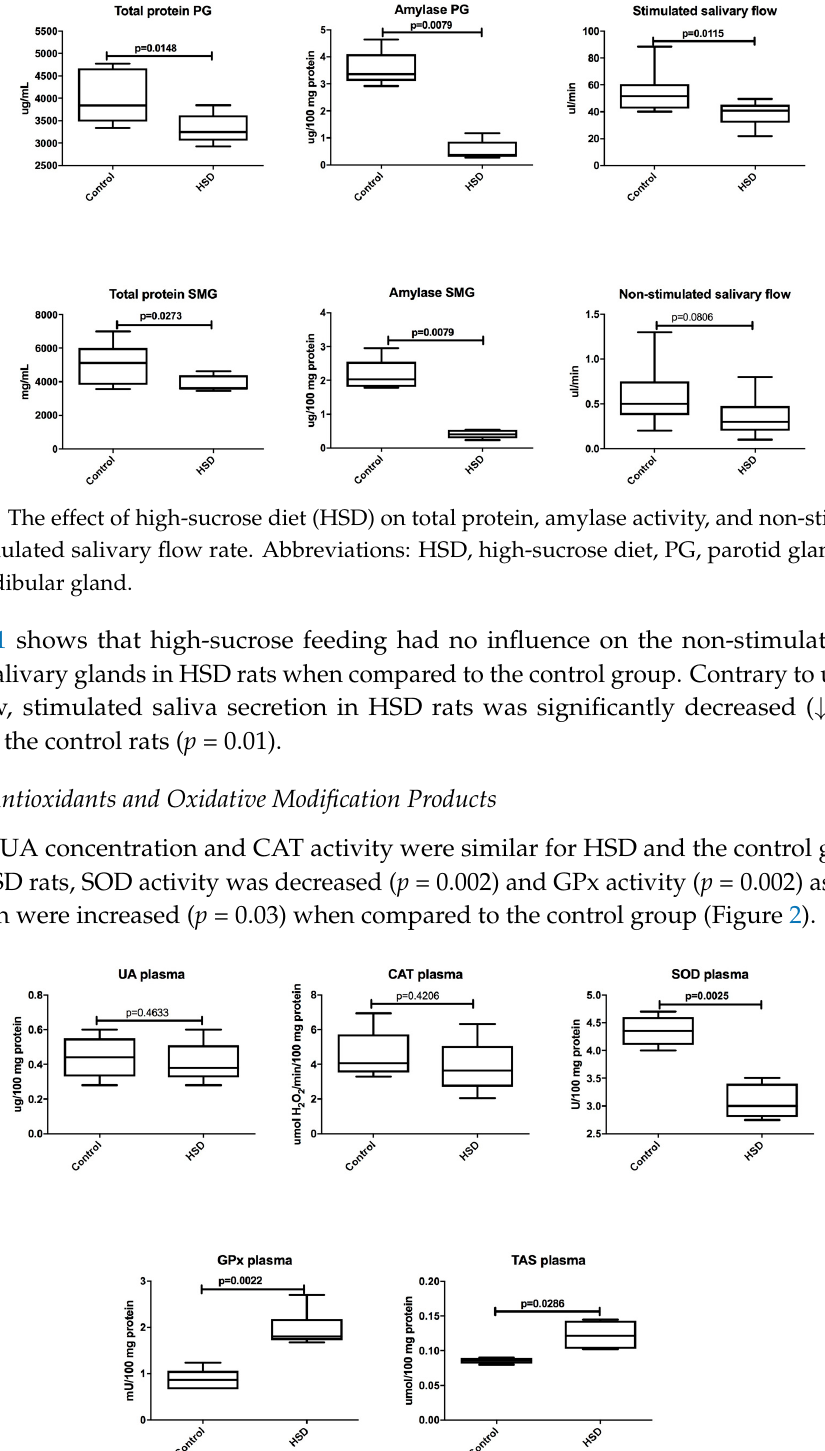
Figure 2. The effect of a high-sucrose diet (HSD) on the plasma antioxidant defense. Abbreviations: CAT, catalase, GPx, glutathione peroxidase, Px, salivary peroxidase, SOD, superoxide dismutase-1, TAS, total antioxidant status, UA, uric